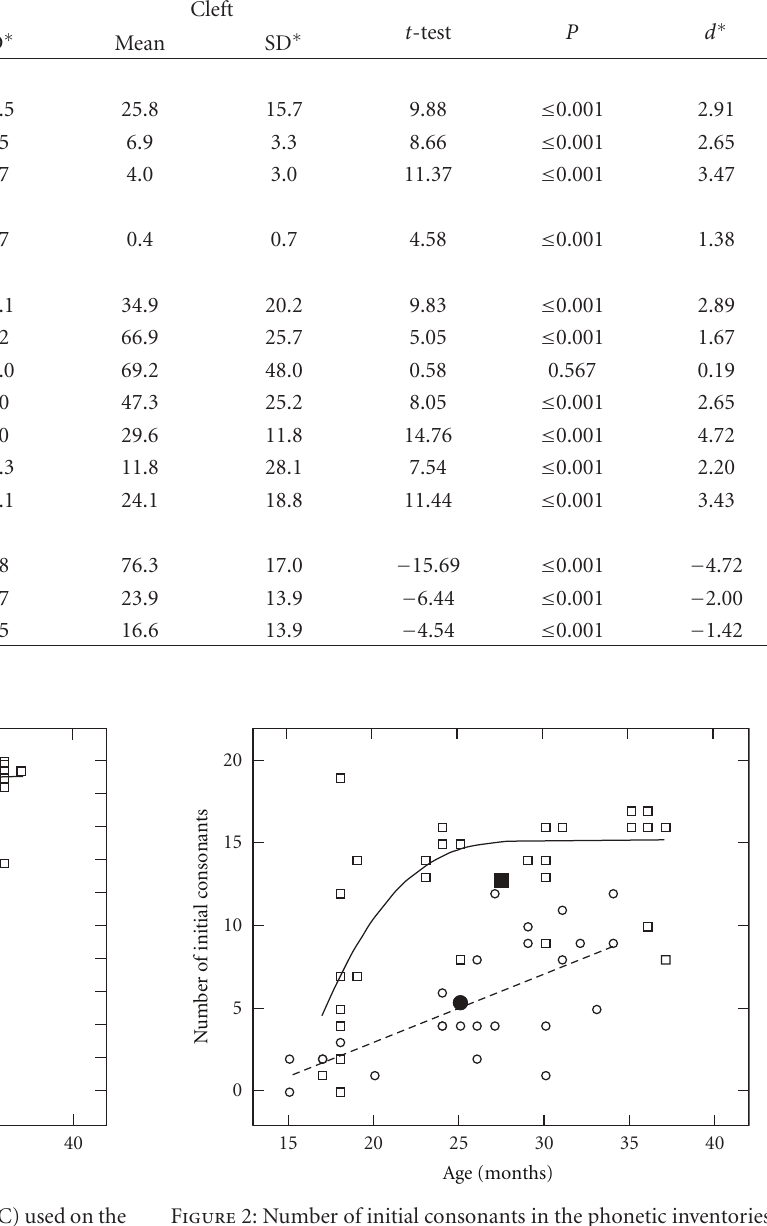
Figure 1: The Percentage of Consonants Correct (PCC) used on the PEEPS for children with CLP (circles) and NC children (squares) across the ages of 18 to 36 months. The linear (CLP: dotted line) and curvilinear (NC: solid line) polynomials and means (filled symbols) are displayed for the groups.